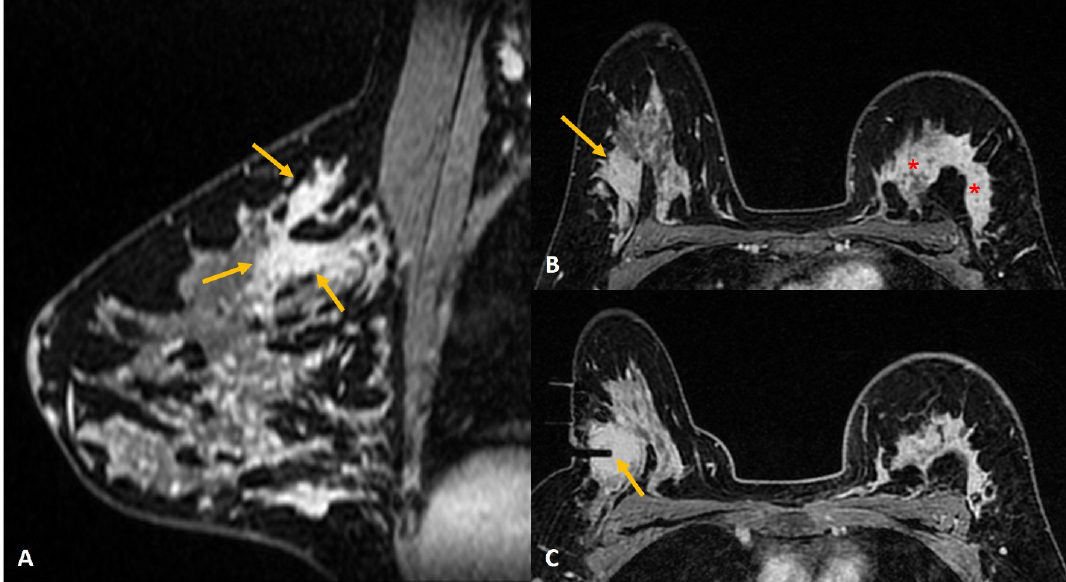
Figure 1. A 36-year lactating mother diagnosed with left breast inflammatory breast cancer underwent staging MRI. ( A ). Sagittal post contrast T1w fat-saturated image showed a segmental non-mass enhancement (yellow arrows) in the upper outer quadrant of the right breast. This was also distinctly FDG avid on PET scan (not shown here). ( B ). Axial staging scan showed diffusely enhancing mass in the left breast correlating with known cancer (red asterisks). Segmental non-mass enhancement was also seen in upper outer quadrant of the right breast (yellow arrow). ( C ). MRI-guided biopsy shows the tip of the obturator in correct location with surrounding post-biopsy hematoma (yellow arrow). Histology was reported as fibrocystic change. (c) Hematoma formation (Figure 2): MRI-guided biopsy, being a vacuum-assisted bi- opsy procedure needing a large bore needle size (generally 8-10G), may cause some bleed- ing and hematoma formation at the site of biopsy. An inquiry should be made in every patient for any known bleeding disorders or history of anticoagulant therapy. In routine cases, the hematoma can be managed with adequate post-procedure local compression. Additional tight breast wrap at the biopsy site can be provided to the patient for continued compression for the next 24–48 h. Aspirating a large hematoma with the use of a vacuum before deploying the marker clip may be helpful in some cases. In the case of an arterial injury leading to significant bleeding, injection of thrombin in the biopsy cavity may help to control active bleeding.